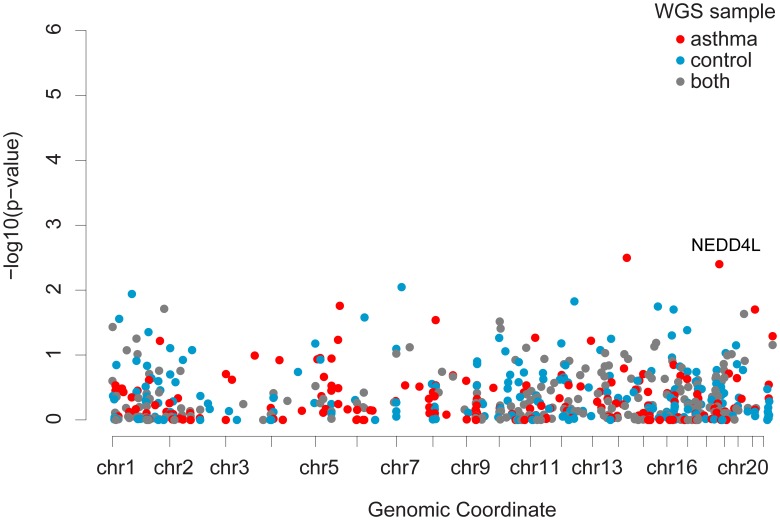
Association results of 593 CNVs to asthma.CNVs for association testing in the full Hutterite pedigree were identified in the 16 sequenced genomes. The points for these CNVs are colored based on the results of the whole-genome sequencing to represent whether the variant was observed in cases only (red), control individuals only (blue), or in both case and control individuals (gray). The genomic position is represented on the x-axis and the −log10(p-value) of the nominal association of each CNV to asthma in the full Hutterite pedigree is on the y-axis.